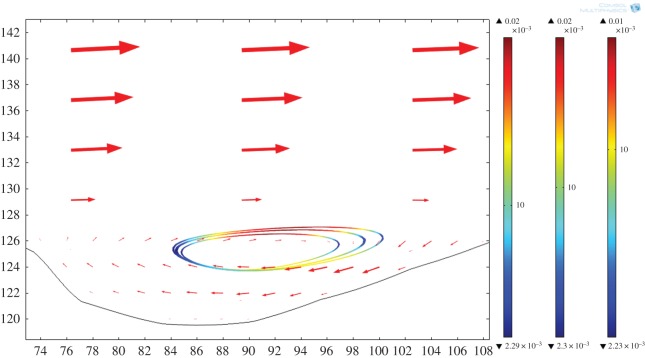
Multiple orbits for three different particle densities that correlate with the major mineral phases comprising the Basement Sill Lower Zone. Inner, 2000 kg m−3 (reference); mid, 2500 kg m−3 (plagioclase); outer, 3000 kg m−3 (orthopyroxene). Colour bars show relative rotational velocity of particles and magma. Magma viscosity, 10 Pa s, particle size 10 mm. Arrows show surface fluid velocity field.